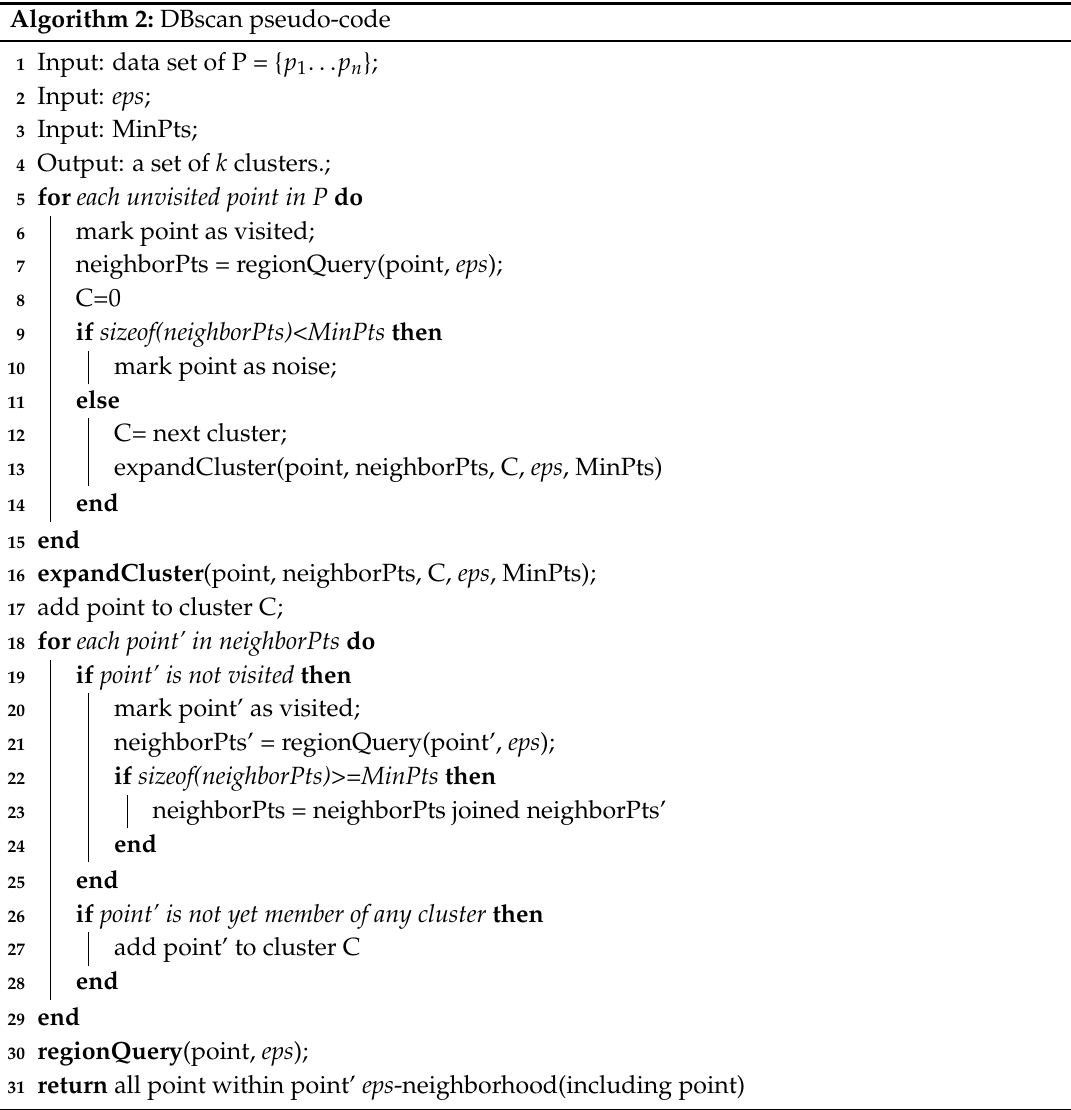
Algorithm 2: DBscan